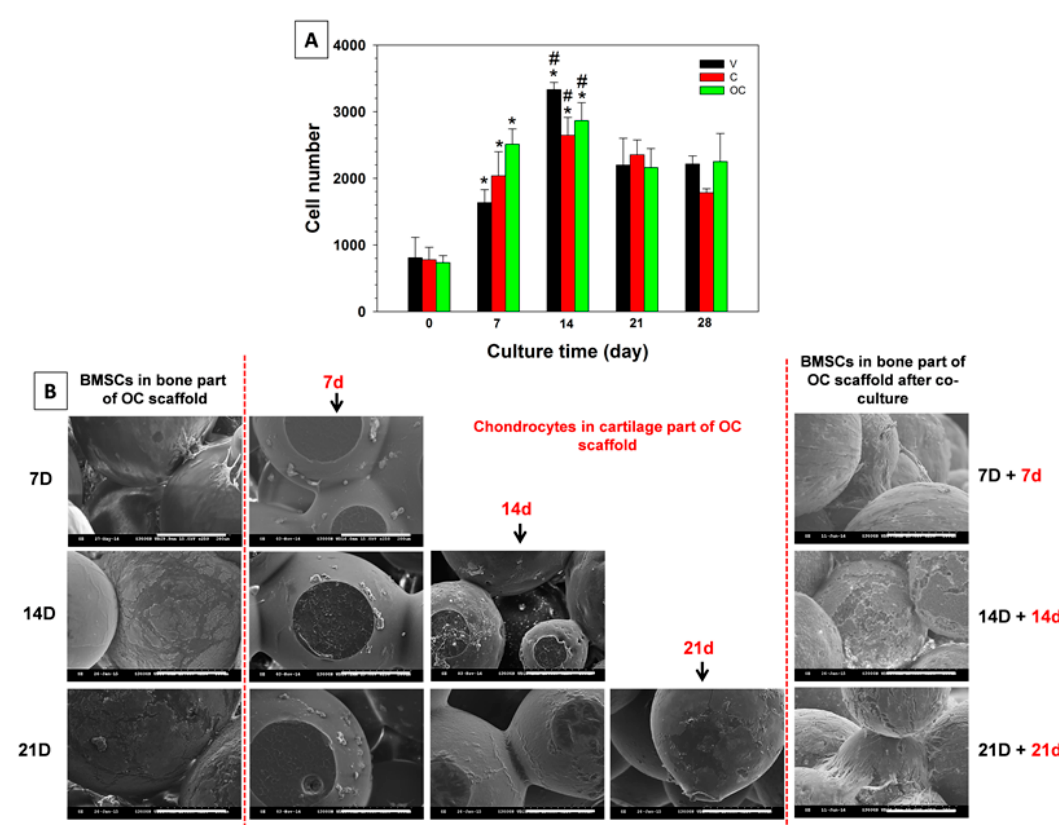
Figure 6. ( A ) Cell numbers of BMSCs from DNA assays when cultured in in V, C, and OC scaffolds up to 28 days. * p < 0.05 compared with day 0, # p < 0.05 compared with day 7 for each scaffold; ( B ) SEM images of the morphologies of BMSCs in the bone part of OC scaffolds before and after co-culture with chondrocytes. 7 D, 14 D, and 21 D represents the morphology of mono-cultured BMSCs in the bone part for 7, 14, and 21 days, while 7 d, 14 d, and 21 d is the morphology of co-cultured chondrocytes in cartilage part of OC scaffolds after 7, 14, and 21 days. 7 D + 7 d, 14 D + 14 d, and 21 D + 21 d denote